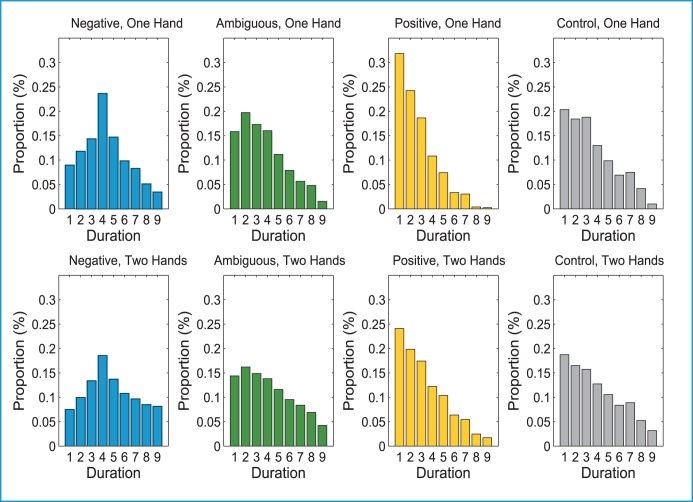
Distributions of note durations for one-handed and two-handed improvisations.